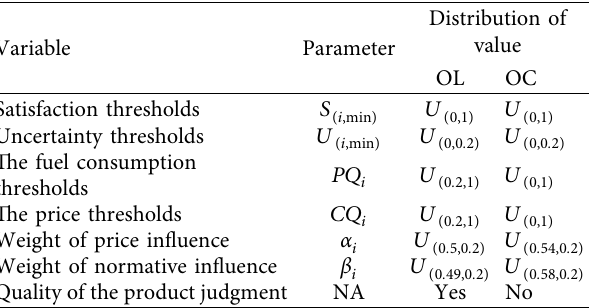
Table 2: Model parameter